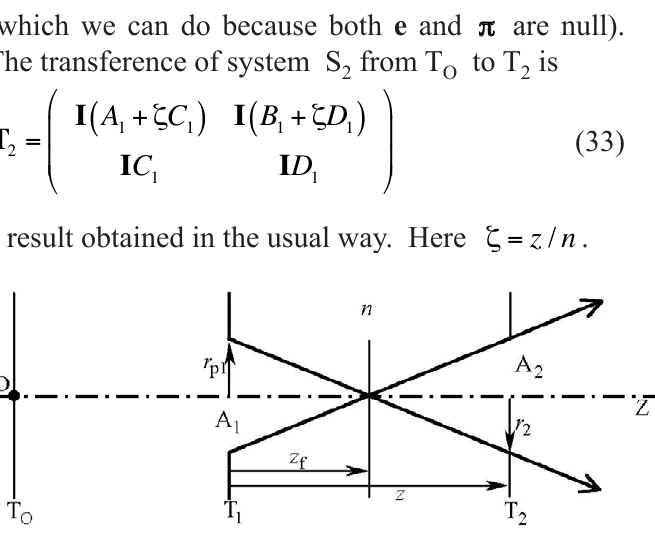
Figure 3 Object point O on longitudinal axis Z refers circular = r > 0 in transverse plane T aperture A of radius r 1 p1 1 verse plane T at distance z downstream in a homogeneous me- 2 dium. Referred aperture A is circular with radius r 2 creases r decreases reaching 0 for z = z and then goes negative. 2 f _ For z = 2 z (as in the figure) r r . The positive radius of A = f 2 1 = r 22 is r p2